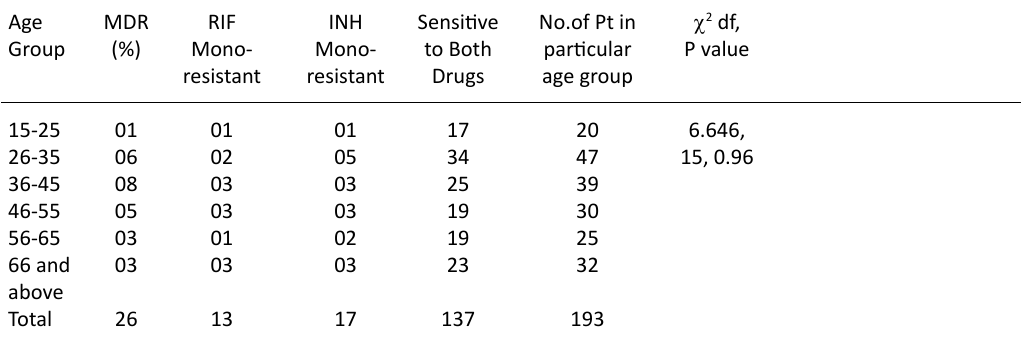
with resistance to rifampicin ( rpoB ) and isoniazid ( katG or inhA ) are shown in Table 6. Out of 26 MDR cases, for rpoB gene WT 2 band is absent in 3 cases at 510-513 gene region and mutation L511P is present. In 6 cases WT 3,4 band is absent at 513- 519 gene region and D516V mutation is present. 16 cases, WT 8 band is absent at 530-533 gene region and in 12 cases MUT3 band is present with S531L mutation. In 2 cases MUT2B band is present at 526- 529 gene region and mutation H526D is present. Table 4. Age wise distribution of patients Age